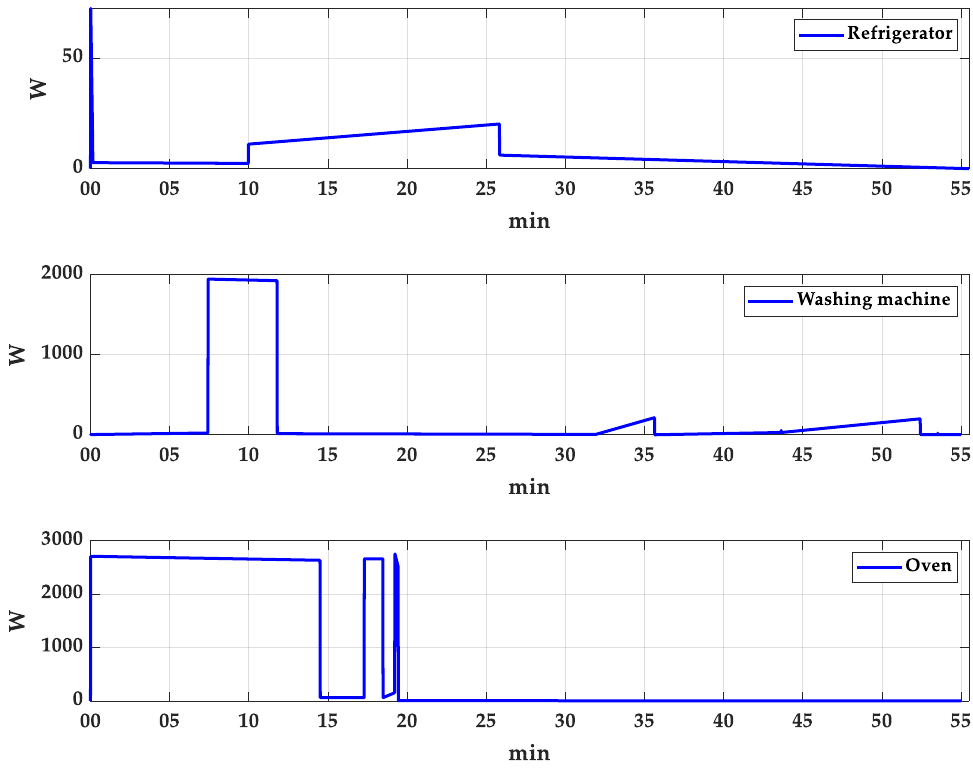
Figure 23. PWL approximations of the load profiles.